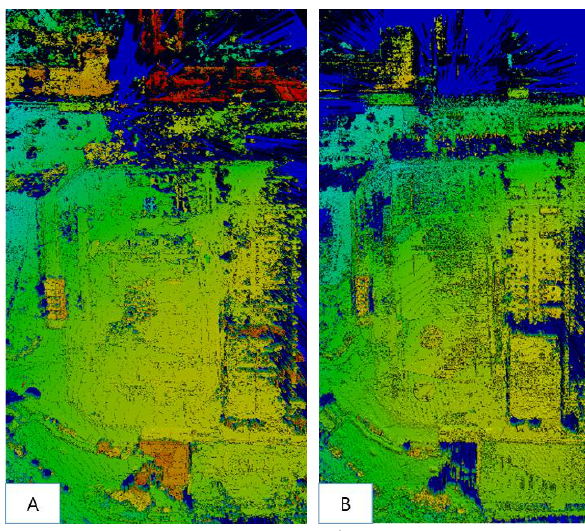
Figure 10. Point cloud results (A: object space-based matching, B: image space-based